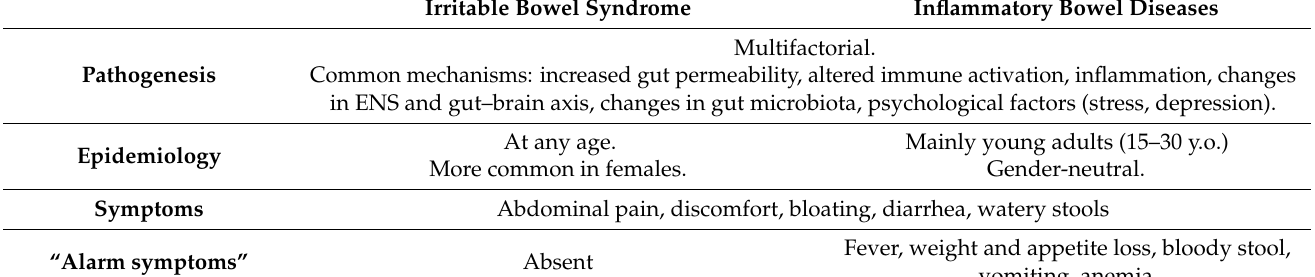
Table 1. Similarities and differences between irritable bowel syndrome (IBS) and inflammatory bowel diseases (IBD). Irritable Bowel Syndrome